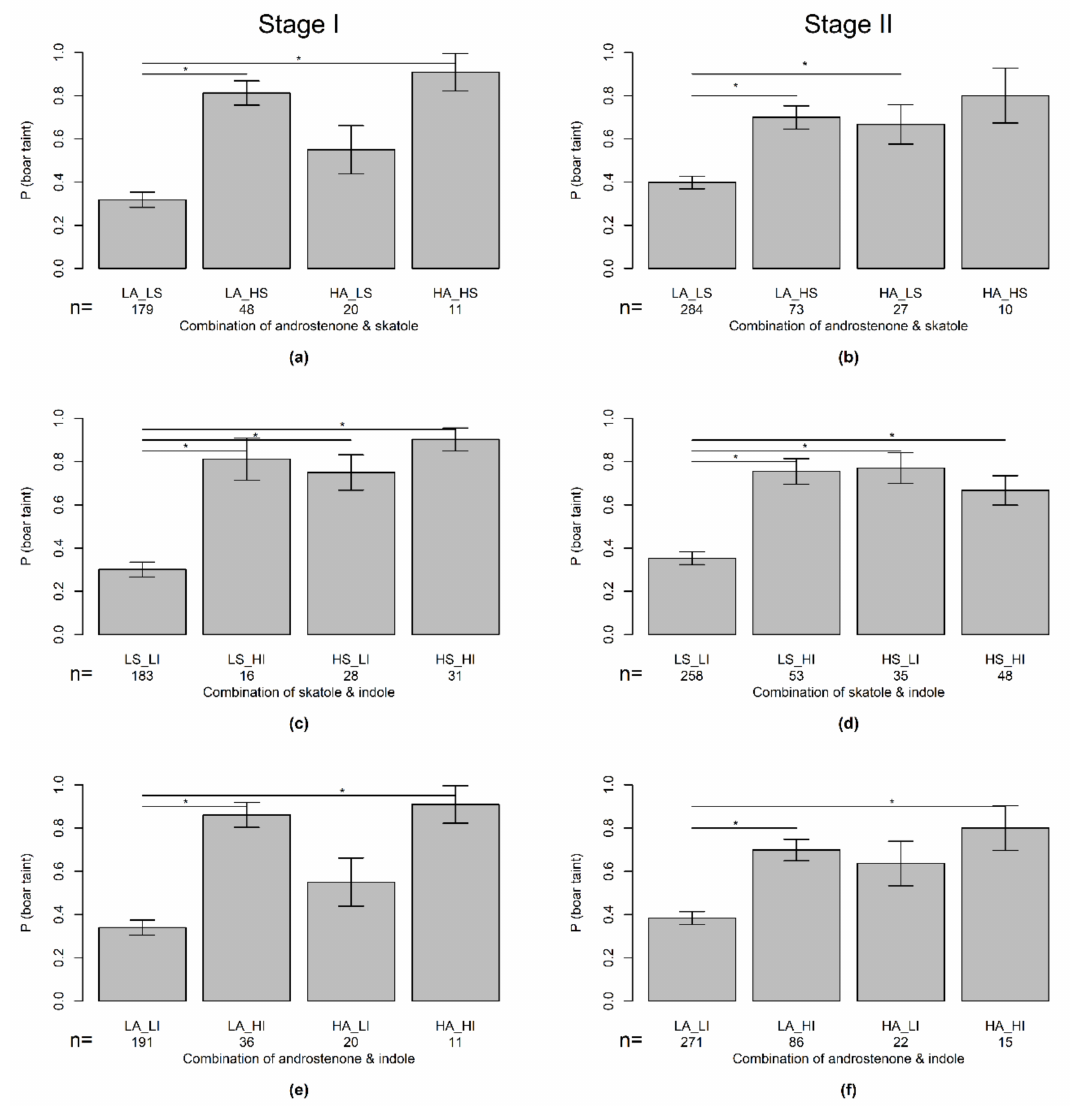
Figure 4. Mean odds of a sample being considered tainted (P (boar taint) by the olfactory panel for combinations of boar taint compounds with concentration lower than (L) of higher than (H) cuto ff level of 2.0 µ g / g, for androstenone (A), 0.25 µ g / g for skatole (S) and 0.15 µ g / g indole (I); ( a ) + ( b